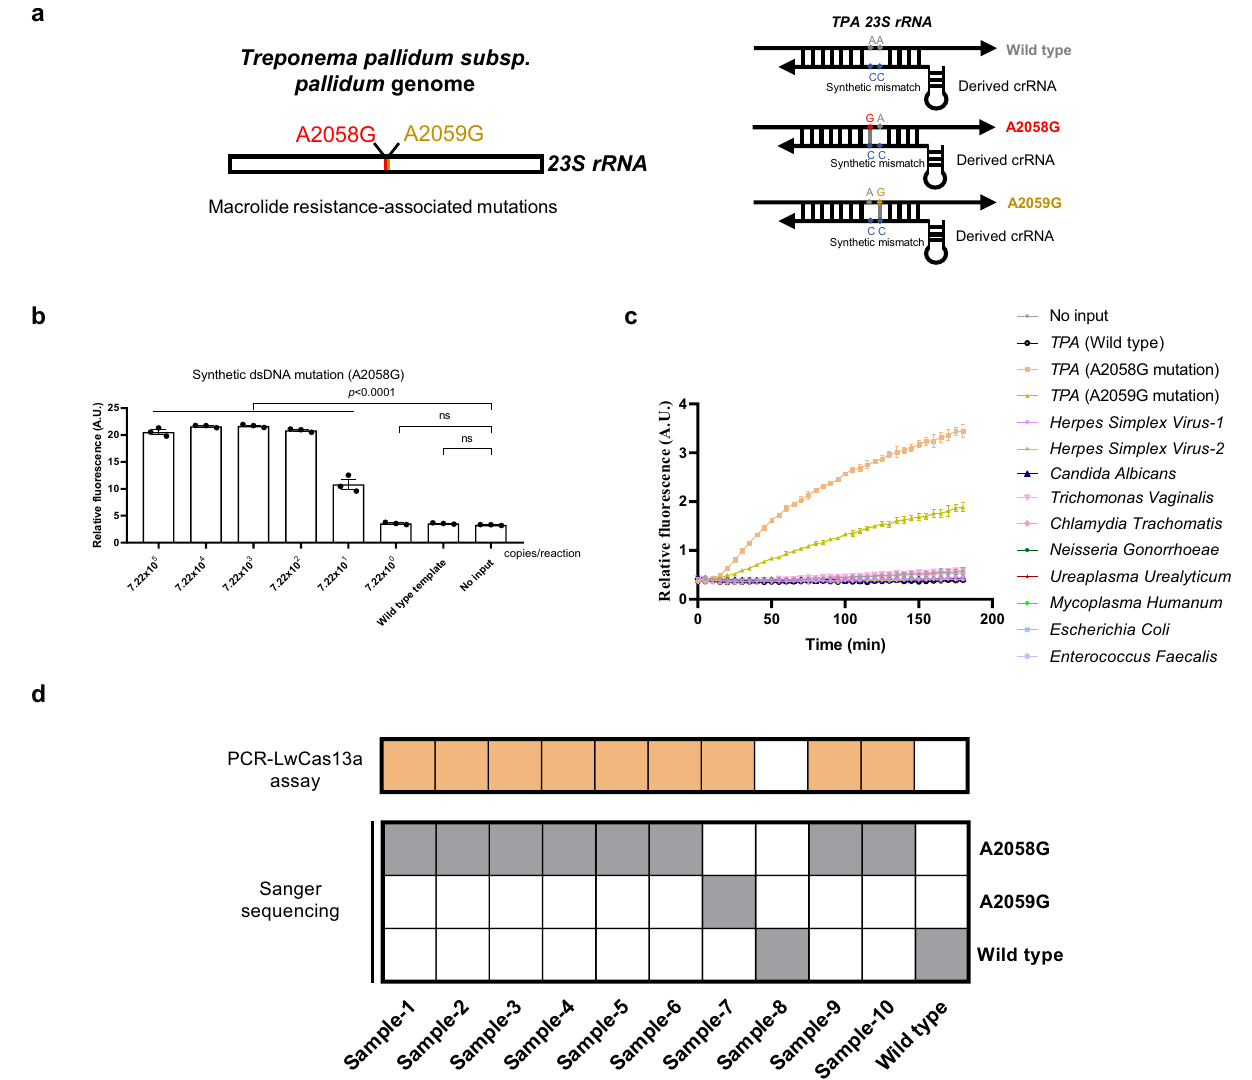
Fig. 4 | PCR-LwCas13a assay for detection of azithromycin resistance. a Schematic of PCR-LwCas13a assay for TPA macrolide resistance genotyping. b Dilution experiment to assess the limits of detection of 23S rRNA mutation (A2058G). c Evaluation of the speci fi city of PCR-LwCas13a assay for 23S rRNA mutationsbytestingapanelofDNAsfrom10genitalmicroorganisms. d Tenclinical samples were evaluated by PCR-LwCas13a assay and validated by Sanger